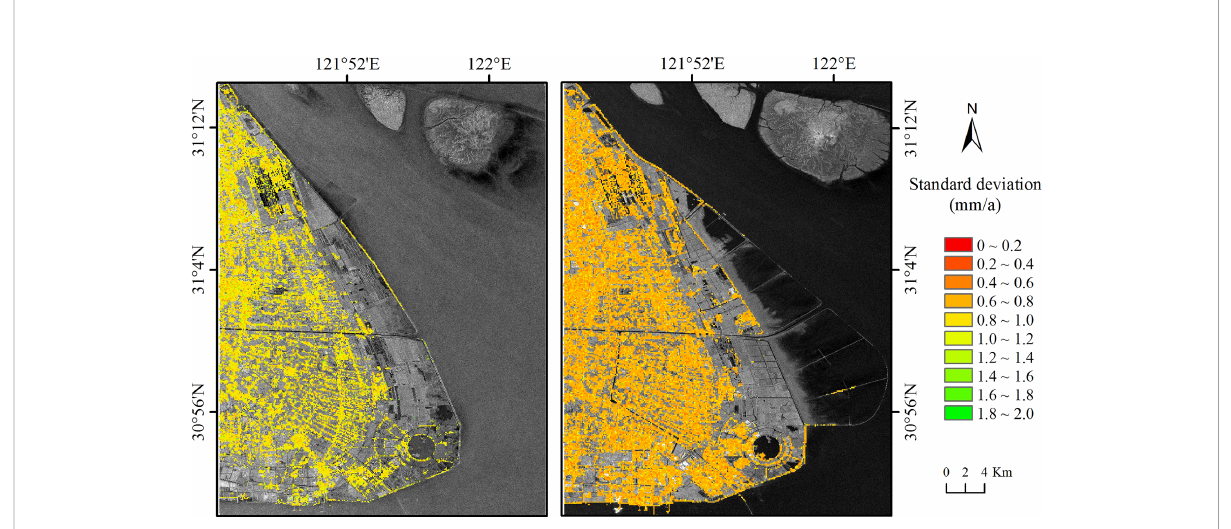
FIGURE 4 Distribution of the standard deviation of the velocity for PS points in the direction of